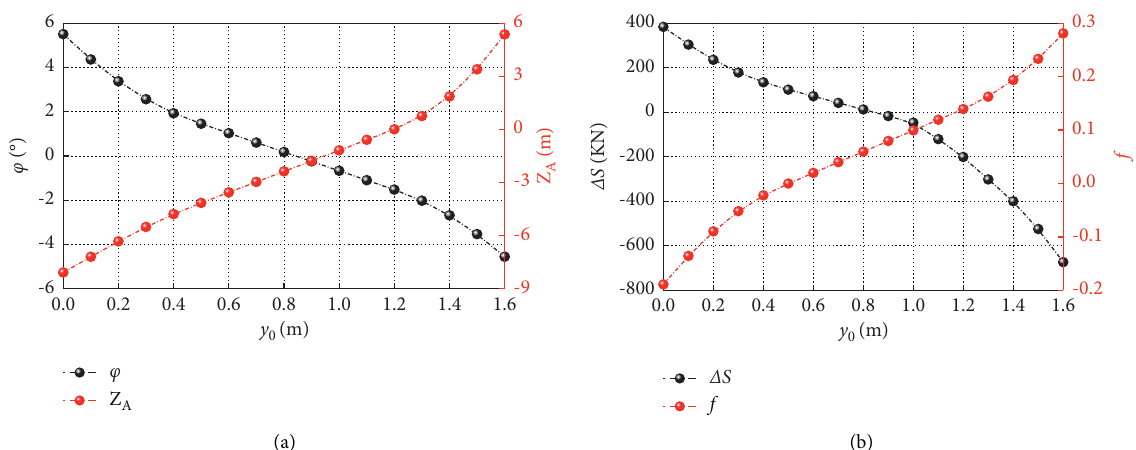
Figure 13: Influence of action position of normal loading on support stability ( h � 4 m). (a) Influence of action position on support rotation. (b) Influence of action position on support sliding.